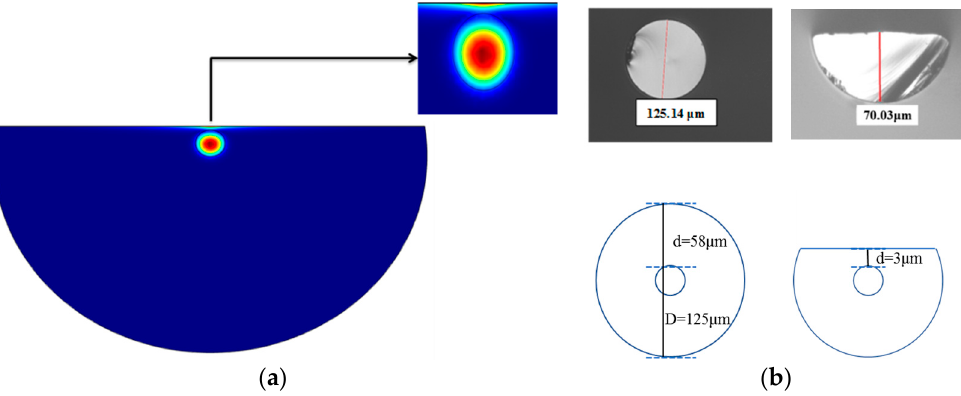
Figure 1. The cross-sectional view of the bimetallic D-shaped optical fiber at the coupling point of the metallic and core modes: ( a ) simulation model and ( b ) the dimensions of the D-shaped optical fiber from microscopy images.